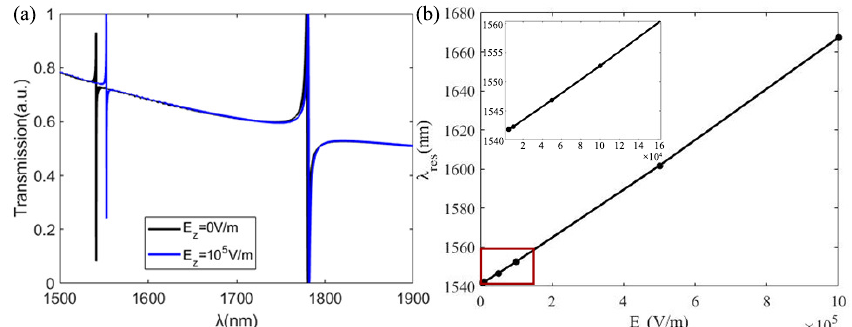
Figure 5. ( a ) Normalized transmission spectrum with applied electric field of E z = 10 5 V/m and without applied electric field in parameter a = 350 nm, r 1 = 80 nm, r 2 = 85 nm, t = 200 nm. ( b ) Variation of resonance wavelength λ res with applied electric field in same parameters, the inset corresponds to the variation in the red rectangle.